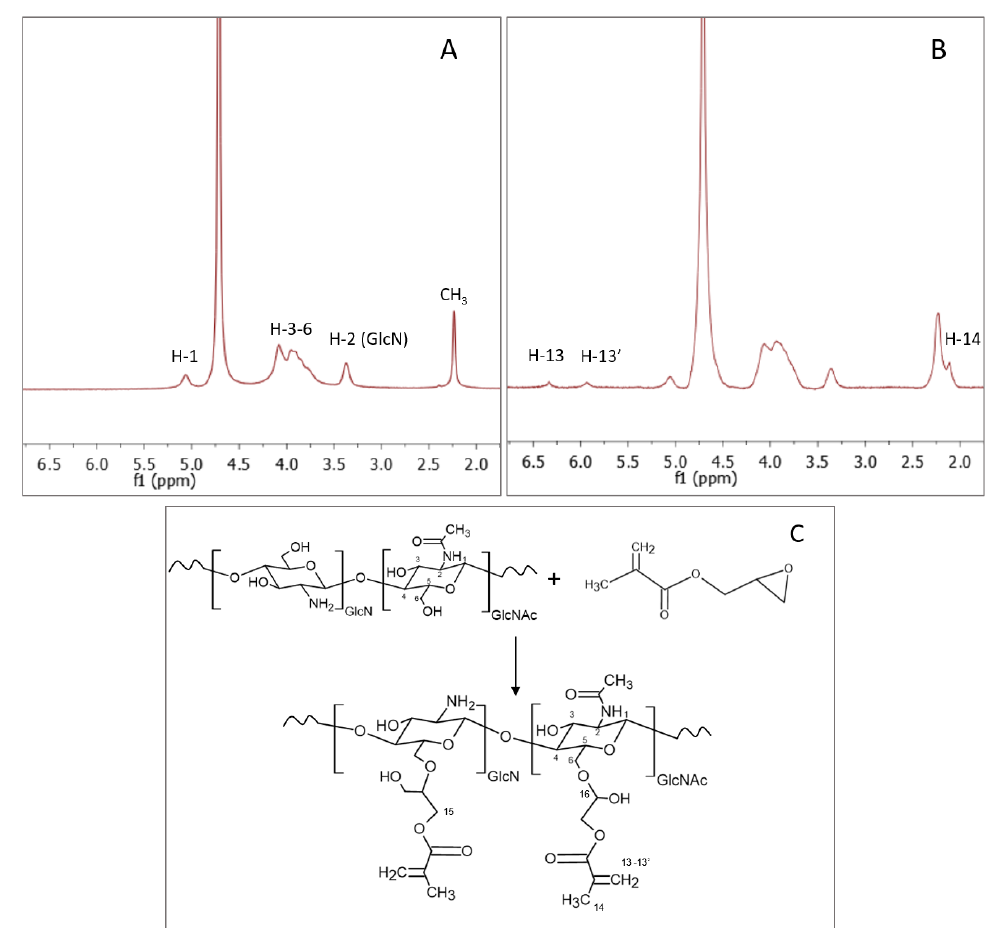
Figure 1. 1 H-NMR spectra of ( A ) pristine CS and ( B ) CS:GMA, and ( C ) scheme of CS modification with GMA.